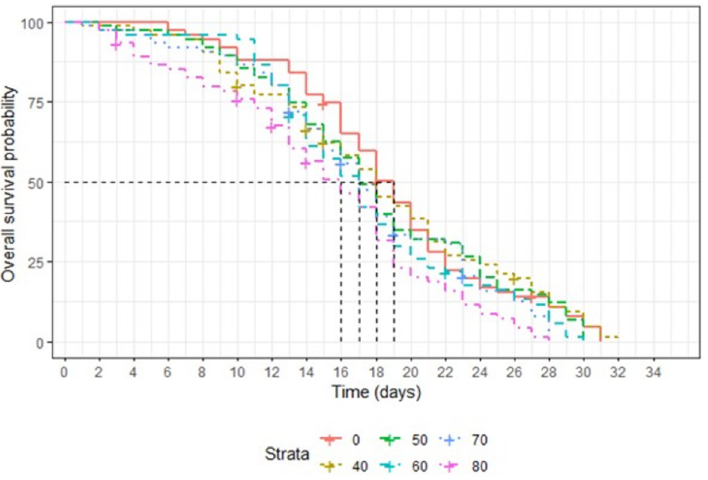
Fig 6. Longevity of non-irradiated and irradiated with different doses of male Ae . aegypti .